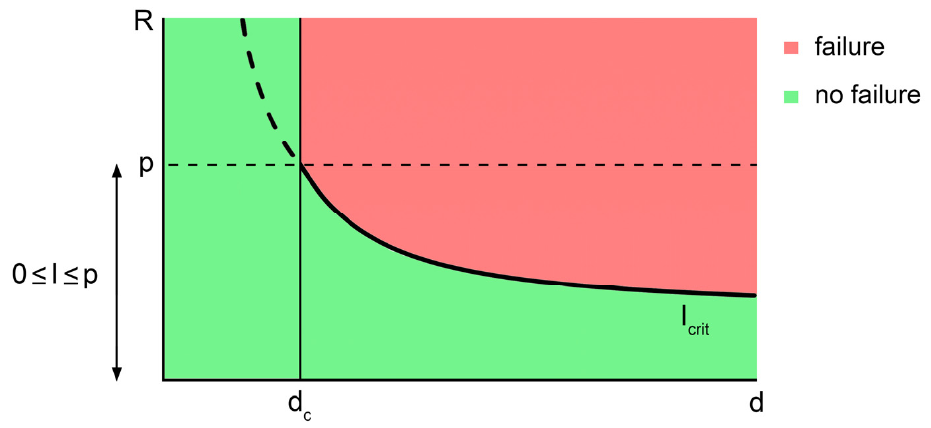
Figure 4. Example of critical curve.